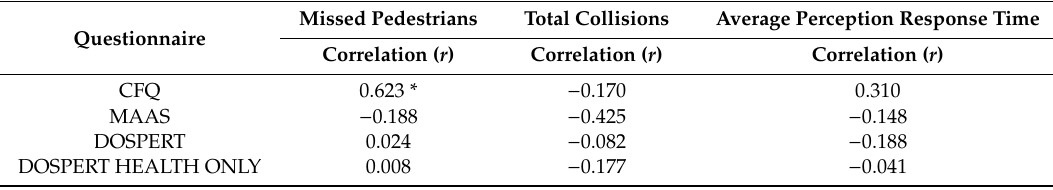
Table 1. Spearman Correlation results of questionnaire scores against total collisions, average perception response time, and missed pedestrians. CFQ = Cognitive Failures Questionnaire; MAAS = Mindful Attention Awareness Scale; DOSPERT = Domain-Specific Risk-Taking